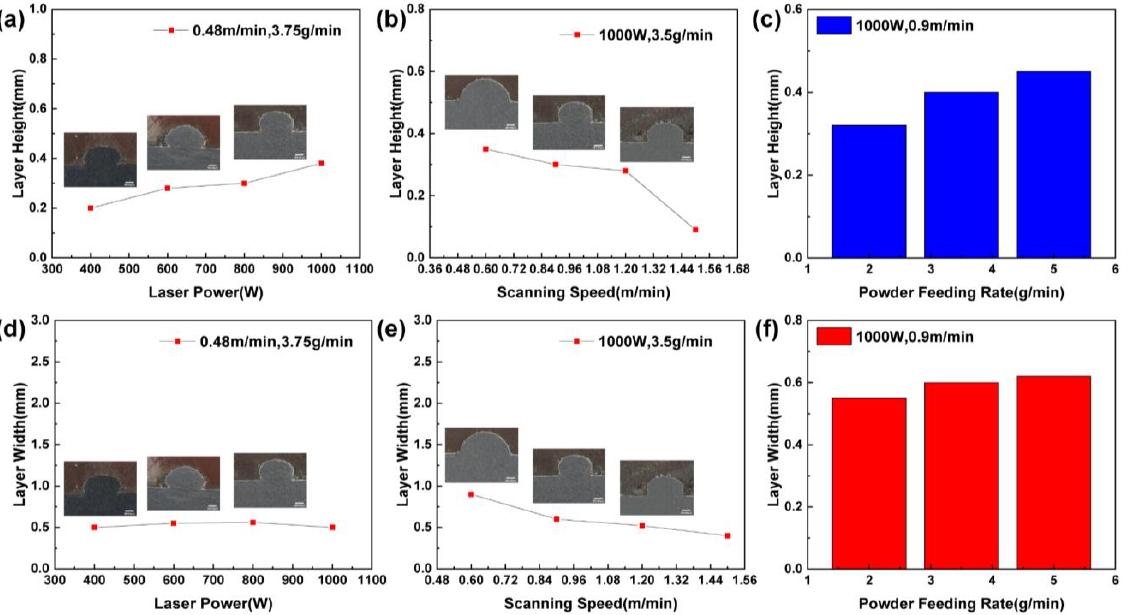
Figure 7. The formation features under different parameters with laser spot diameter of 1.0 mm: ( a ) Laser power and layer height, ( b ) Scanning speed and layer height, ( c ) Powder feeding rate and layer height, ( d ) Laser power and layer width, ( e ) Scanning speed and layer width, ( f ) Powder feeding rate and layer width.